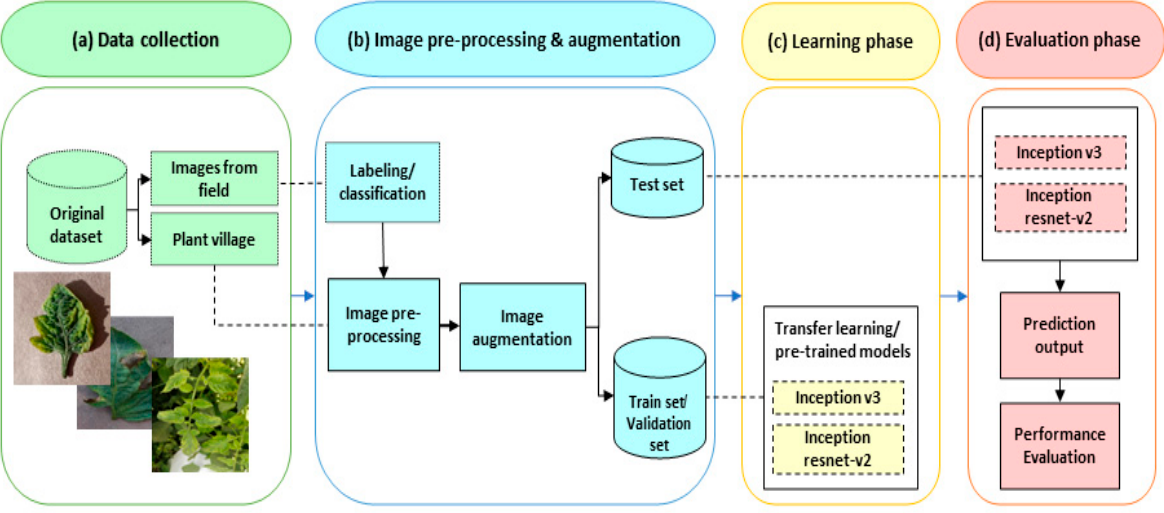
Figure 1. Diagram for identifying tomato leaf diseases.